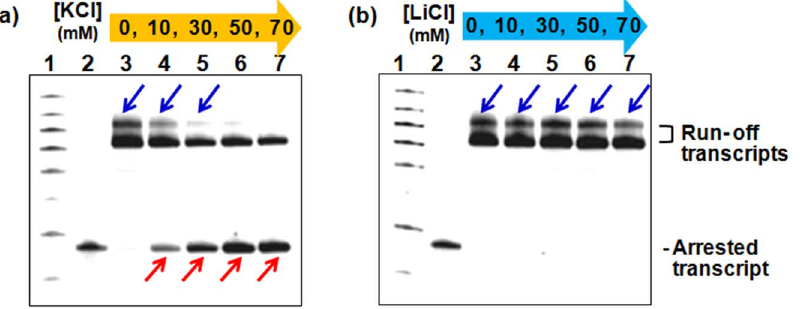
Figure 3. Effect of the G-quadruplex stability on the production of slipped and arrested transcripts. Denaturing gel electrophoresis of products of transcription reactions carried out for 90 min at 37 u C using Q5 template. Reaction mixtures contained 0.3 m M T7 polymerase and 1.5 m M DNA template in a buffer containing 40 mM Tris-HCl (pH 8.0), 8 mM MgCl 2 , and 2 mM spermidine and various concentrations of (a) KCl or (b) LiCl. Lane 1 shows 10-nt size marker, lane 2 shows 35-nt RNA, and lanes 3 to 7 show transcription products in the presence of 0, 10, 30, 50, and 70 mM (a) KCl or (b) LiCl. Blue and red arrows indicate the slipped and arrested transcripts, respectively.